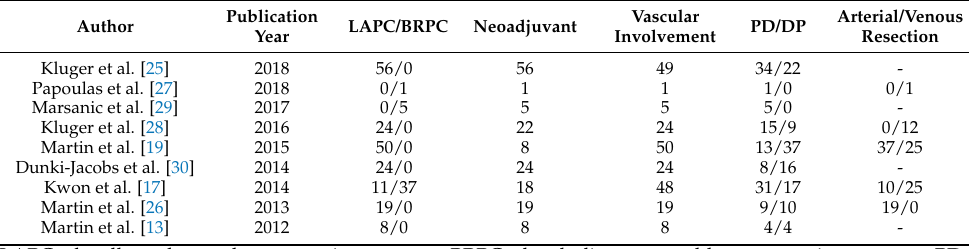
Table 2. Tumour and treatment characteristics of all included